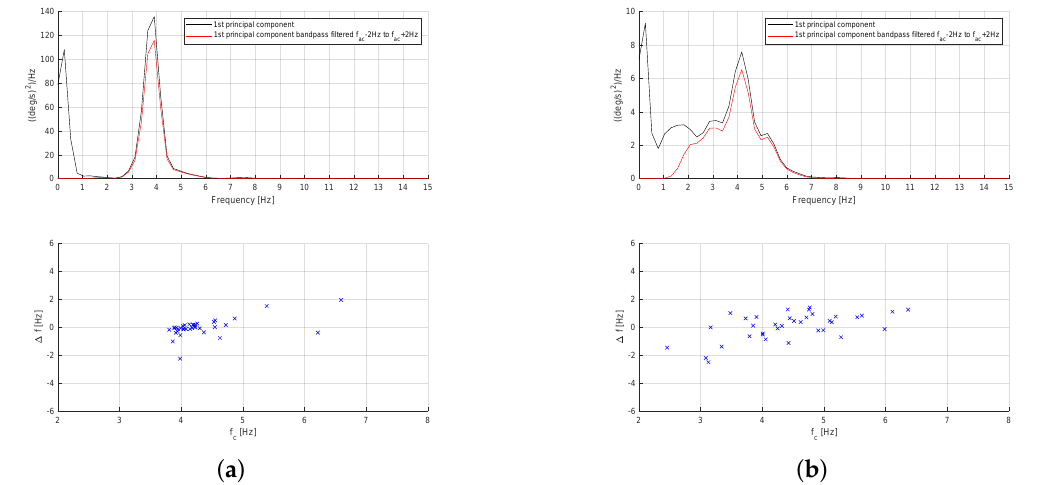
Figure 13. Power spectral density and Inter-cycle variation of gyroscope signal frequency measured at the head of patients with essential tremor and cervical dystonia. ( a ) Patient-107, with essential tremor (from A2 group); ( b ) Patient-48, with cervical dystonia (from B2